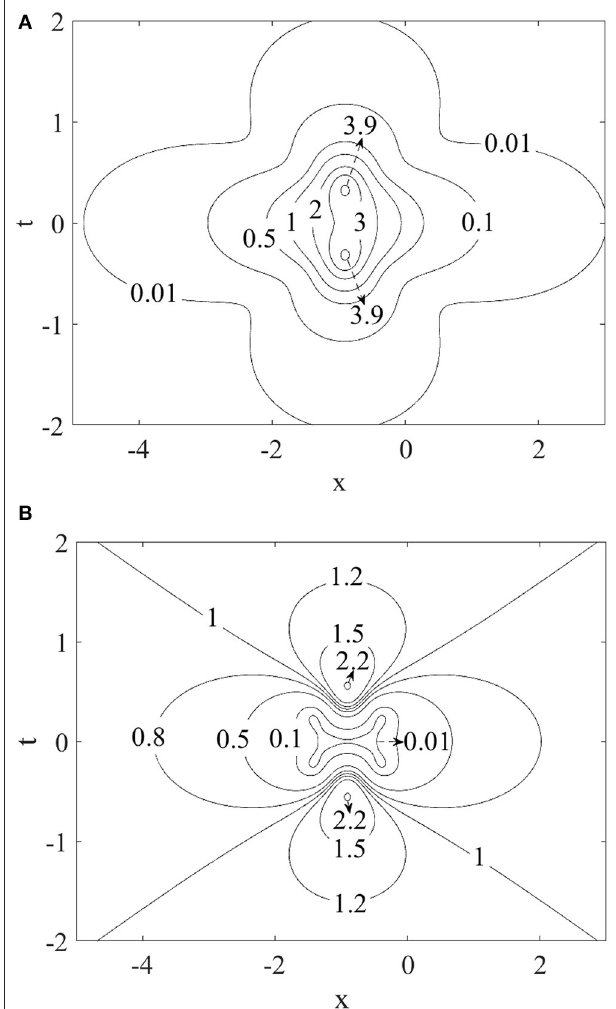
FIGURE 5 | (A) Planar contour plot of the wave intensities | A | 2 , illustrating the “double peak” structure. (B) Planar contour plot of the wave intensities | B | 2 , illustrating the “double peak”